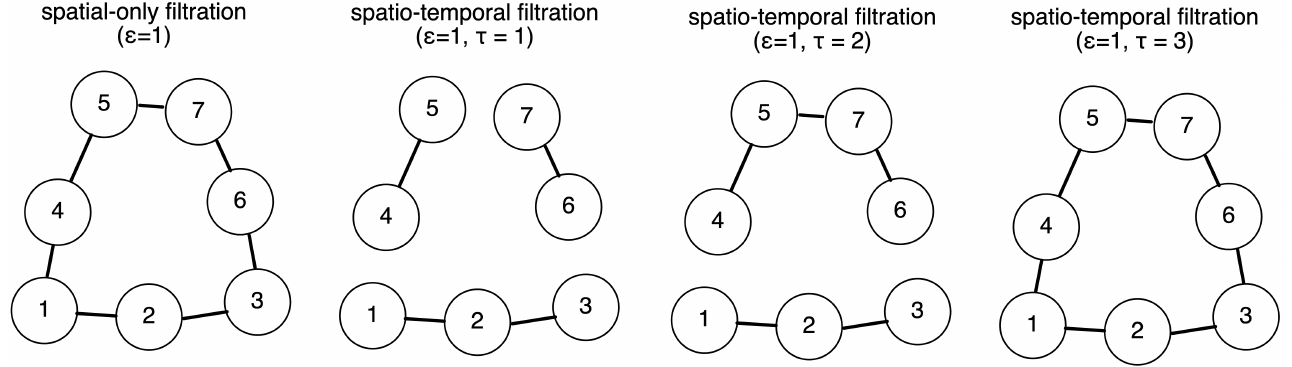
Figure 2. Intuitive example of the temporal filtration. Presented here are seven data points which are marked by their time stamps (when they were measured). In all four cases, we considered the case where the spatial threshold (cid:101) of the nerve ball around each data point was one (which, in our case, only contained every data point’s nearest neighbor and not the second-nearest neighbor). If we only performed the spatial filtration, we would consider them all to be connected. However, that would not match the temporal skeleton. Instead, we could set a temporal constraint τ such that only if two data points that were spatially (in the feature space) proximal to each other were also measured temporally close to each other would their edge be included. If τ is small (e.g., one time step apart), then we have a fine resolution temporal skeleton which separates the data points into three